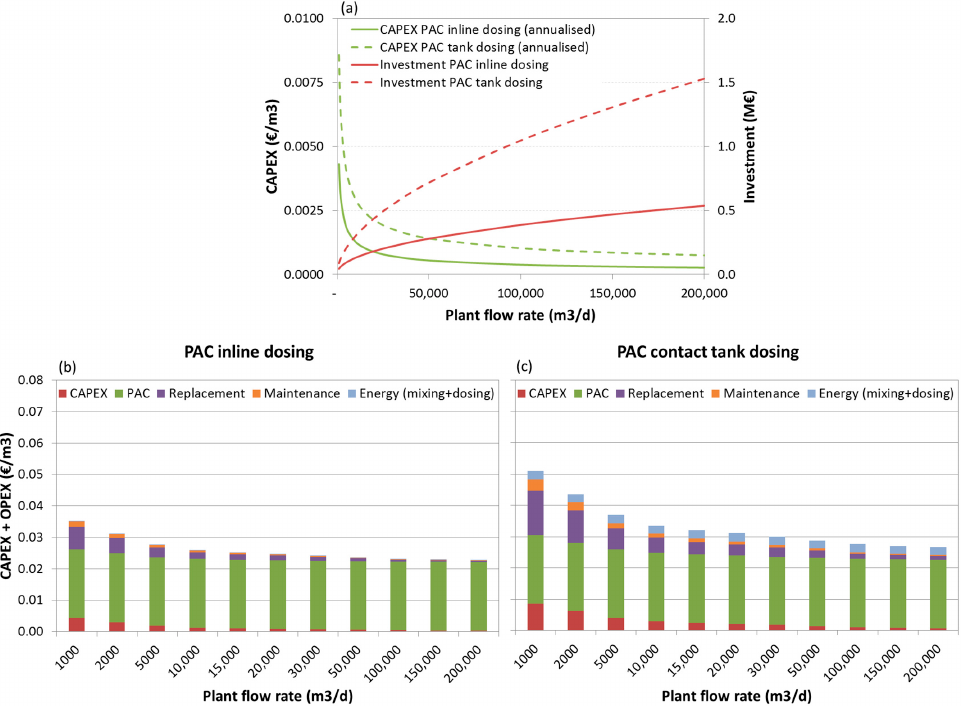
Figure 6. Investment costs and annualised CAPEX ( a ) and total (CAPEX+OPEX) production costs breakdown for scenario 1, dosing 8 mg/L PAC inline ( b ) and 8 mg/L PAC to tank ( c ).